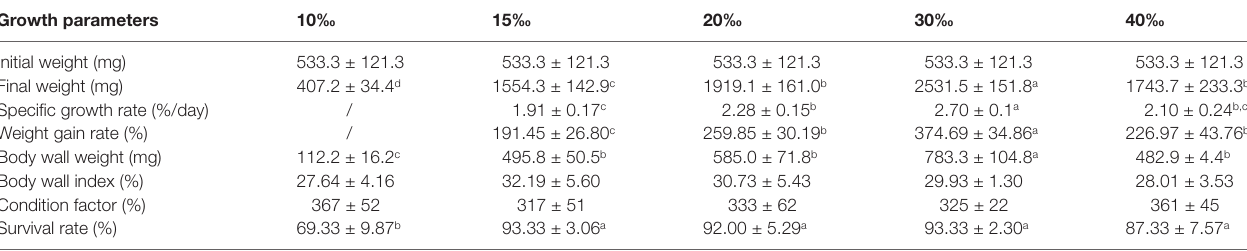
TABLE 1 | Growth performance of U. unicinctus juveniles reared at different salinities for 8 weeks. Growth